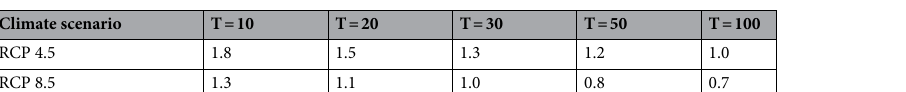
Climate scenario T = 10 T = 20 T = 30 T = 50 T = 100 RCP 4.5 1.8 RCP Table 2. Change of annual maximum amount of consecutive precipitation with five return periods (once in T years) during the period 1991–2050 in Xiongan New Area based on climate projection data (unit: %).